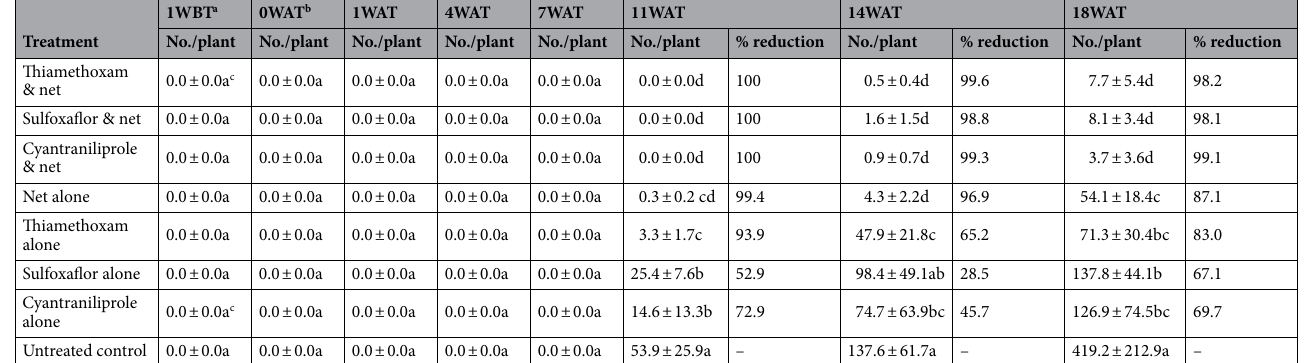
Table 2. Effects of different treatments on Bemisa tabaci adult populations during the whole growing season (greenhouse trial II, 2019). a WBT, weeks before transplanting; 1 WBT is the time of root drenching. b WAT, weeks after transplanting; 0 WAT is the time of seedling transplanting; 11 WAT is the time of first fruit harvest; 18 WAT is the end of the greenhouse trials. c In the columns, the data are the means ± SD of four replications, with 10 plants per replicate. Means followed by the same letter are not significantly different at P = 0.05 level according to the LSD